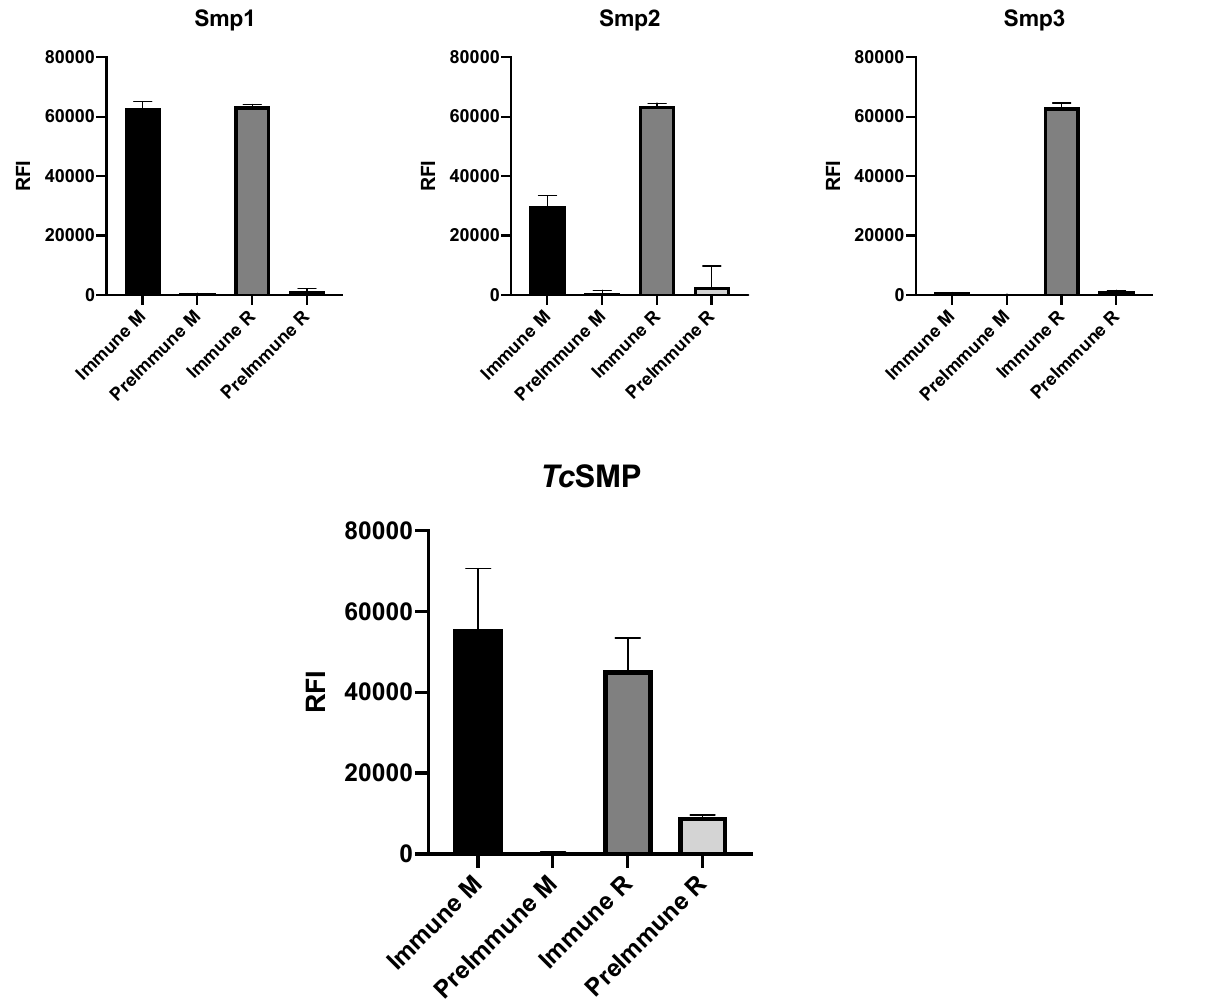
Figure 5. Immune sera reactivity of predicted epitopes. Upper panels: ability of biotinylated peptides Smp1, Smp2, and Smp3 to recognize antibodies present in mouse immune sera (M) and rabbit (R) immune sera, following immunization with recombinant Tc SMP. Lower panel: immune sera reactivity of mouse immune sera (M) and rabbit (R) immune sera, against the recombinant Tc SMP protein.